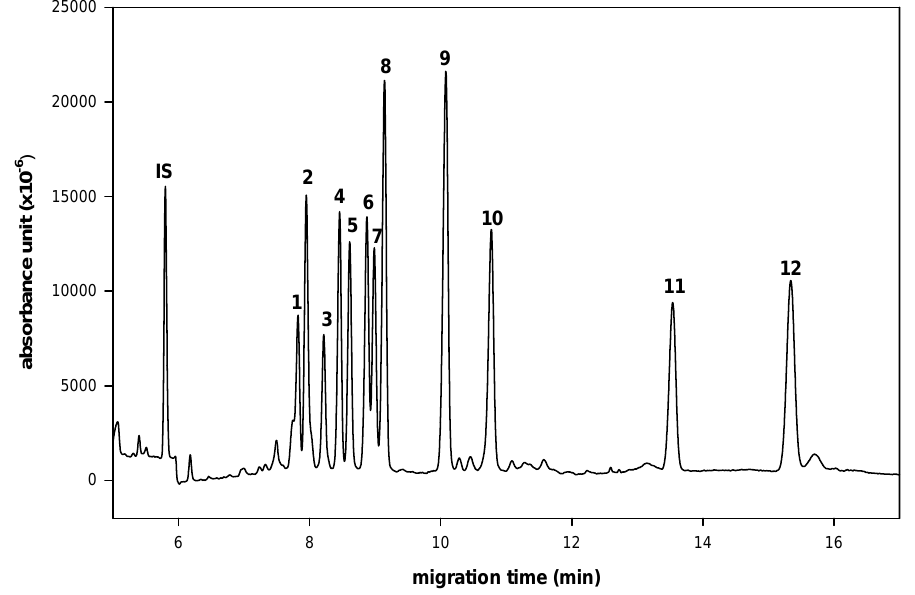
Figure 2. Electrophorogram of 2,3-naphthalene diamine derived monosaccharides. Peaks: 1= Rha-NAIM; 2= GalNAc-NAIM; 3= SA-NAQ (sialic acid-naphthyl benzo[ g ]- quinoxaline); 4= Xyl-NAIM; 5= Rib-NAIM; 6= Glc-NAIM; 7= Man-NAIM; 8= Ara- NAIM; 9= Fuc-NAIM; 10= Gal-NAIM; 11= GlcA-NAIM; 12= GalA-NAIM. Conditions: